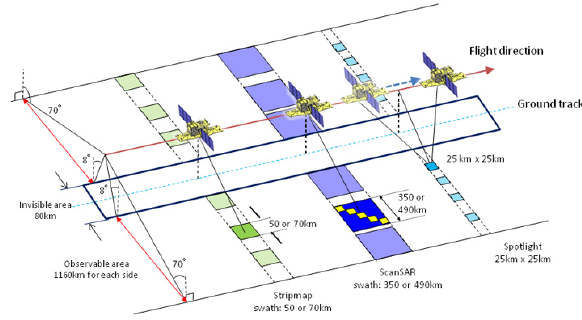
Figure 3. ALOS-2 / PALSAR-2 observation modes c (cid:13)